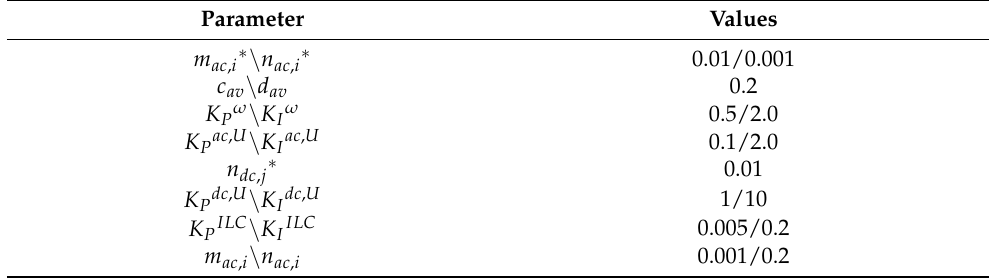
Table 3. Main control parameters of